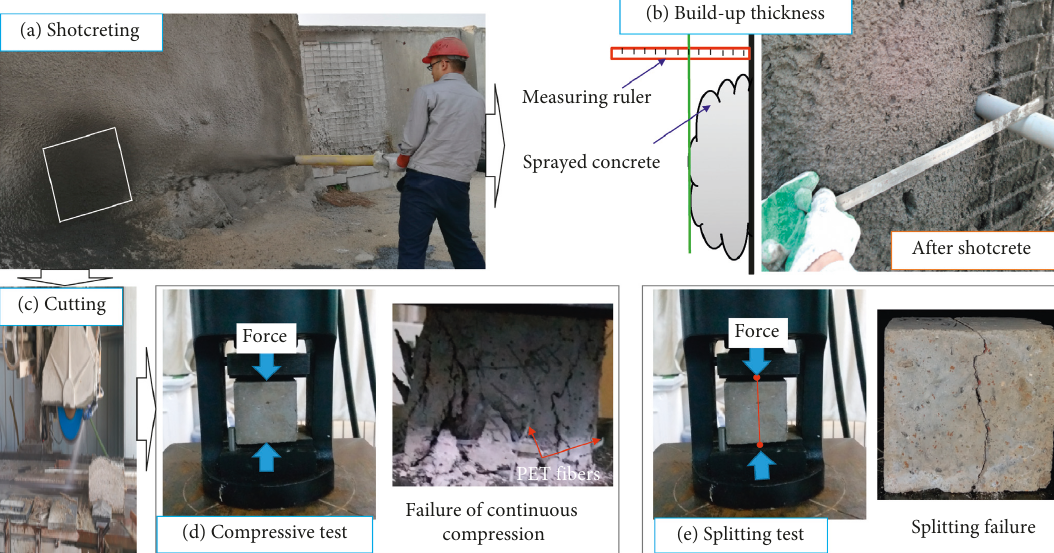
Figure 4: Measurement of build-up thickness and tests of mechanism properties of wet-mix shotcrete. Table 5: Results of orthogonal tests for wet-mix shotcrete reinforced by PET